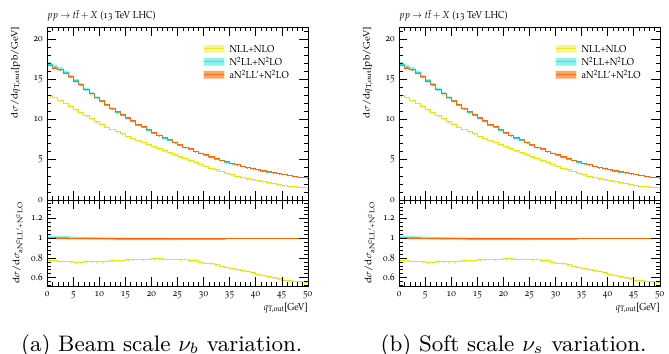
(b) Soft scale ν s variation. / d q T , out . t ¯ t